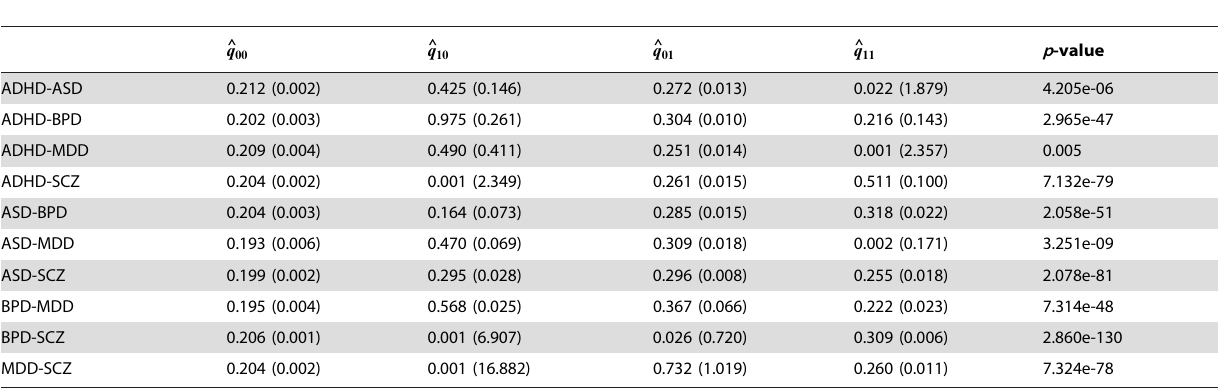
Table 3. GPA results for all pairs of the five psychiatric disorders with the CNS set as annotation.